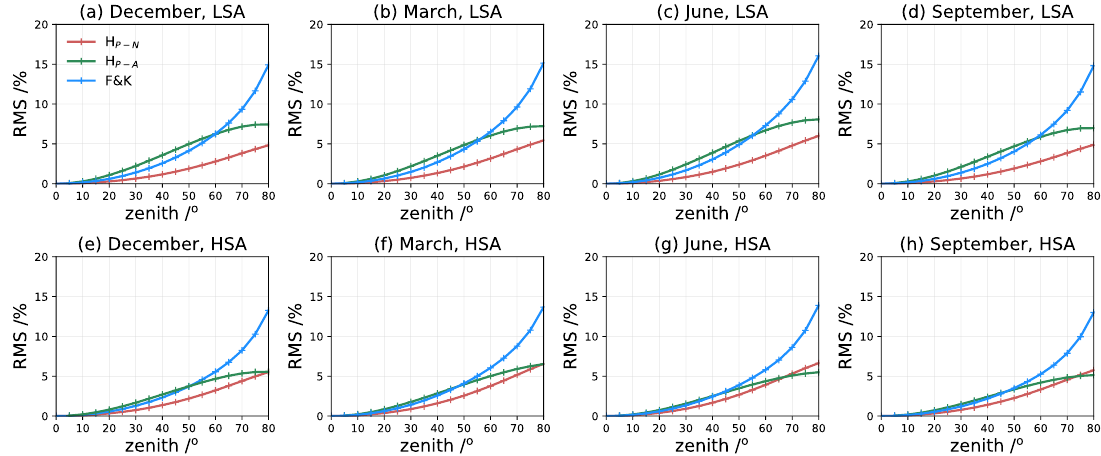
Figure 11. Same as Figure 5 but for LEO satellite at 1400 km.